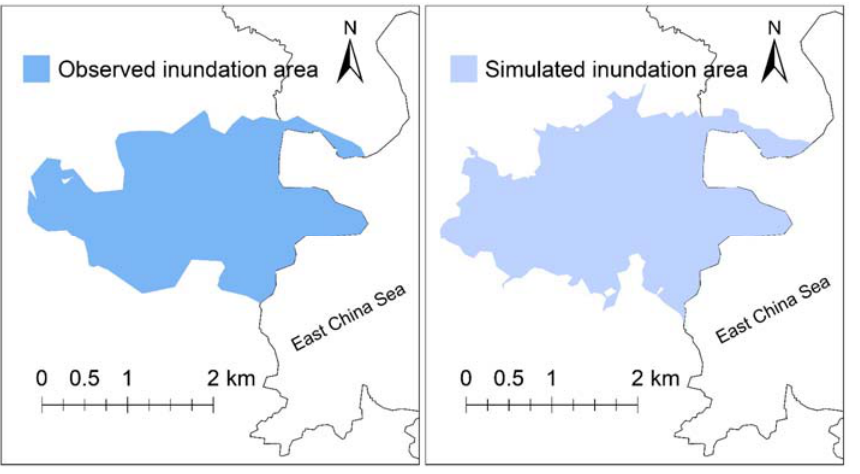
Figure 3. The comparison of the observed inundation map with the simulated inundation area of a 10-year storm-tide event in Muluan Bay of Xiamen. Population exposure analysis was conducted to determine the extent to which the population will be exposed to the inundation area. Population census data were overlaid with the flood-area map, to extract the population exposed to a given flood event. Finally, the expected annual population (EAP) exposed to coastal flooding was calculated to represent the average value of the population affected in a given